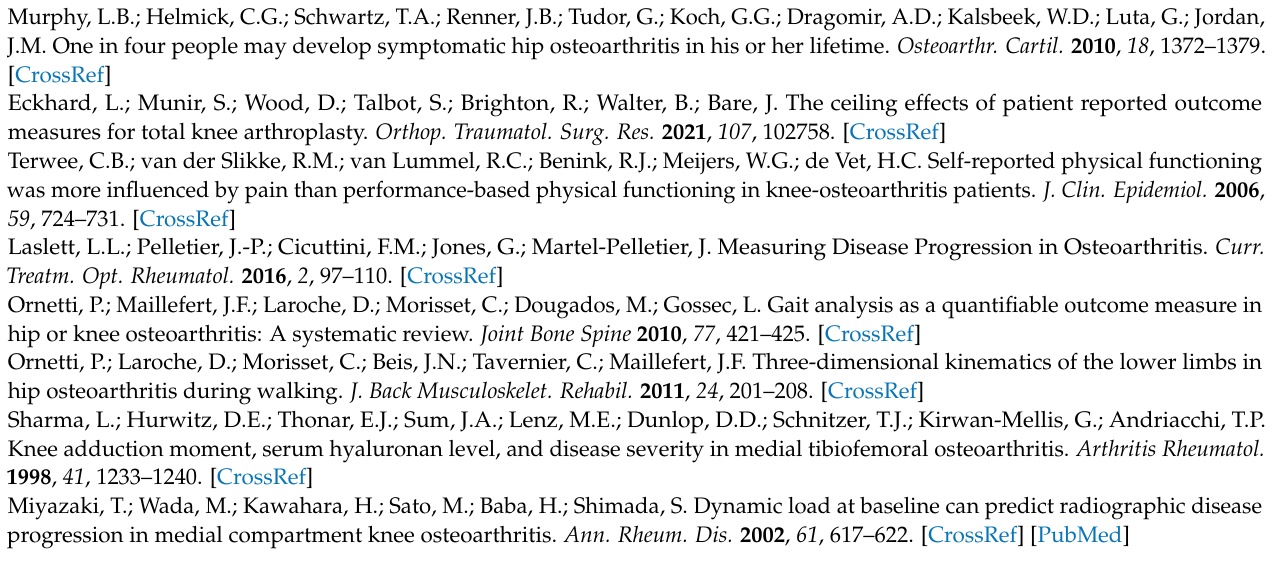
Figure S1: Comparison between all participant groups for the contralateral/right leg, Figure S2: Comparison between patients with knee OA and controls for the contralateral/right leg, Figure S3: Comparison between patients with hip OA and controls for the contralateral/right leg, Figure S4: Comparison between patients with knee OA and patients with hip OA for the contralateral/right leg, Figure S5: Association between KOOS subscores and kinematic trajectories., Figure S6: Association between HOOS subscores and kinematic